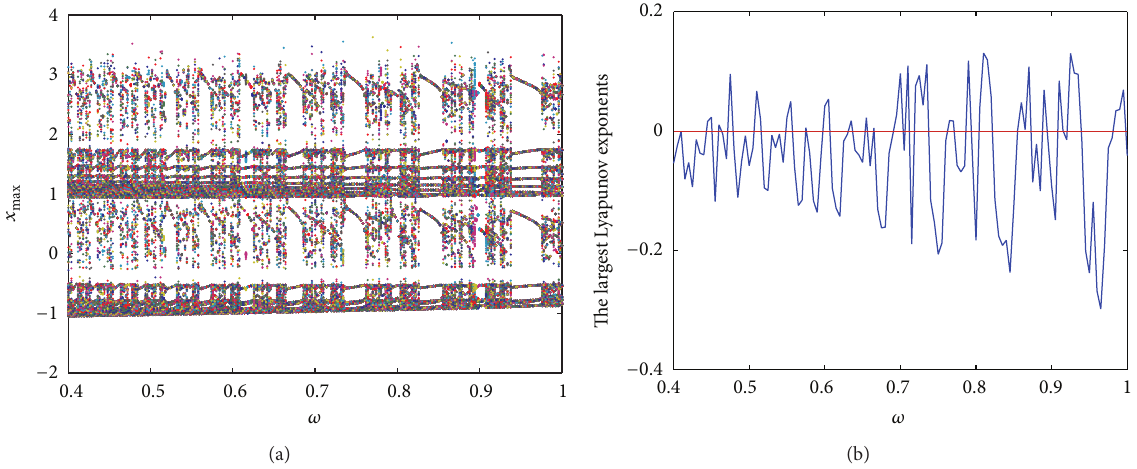
Figure 4: Dynamical behavior of the system (6) with 𝜔 in [0.4, 1] and 𝐴 = 0.2 : (a) bifurcation diagram for increasing 𝑤 ; (b) the largest Lyapunov exponent versus 𝜔